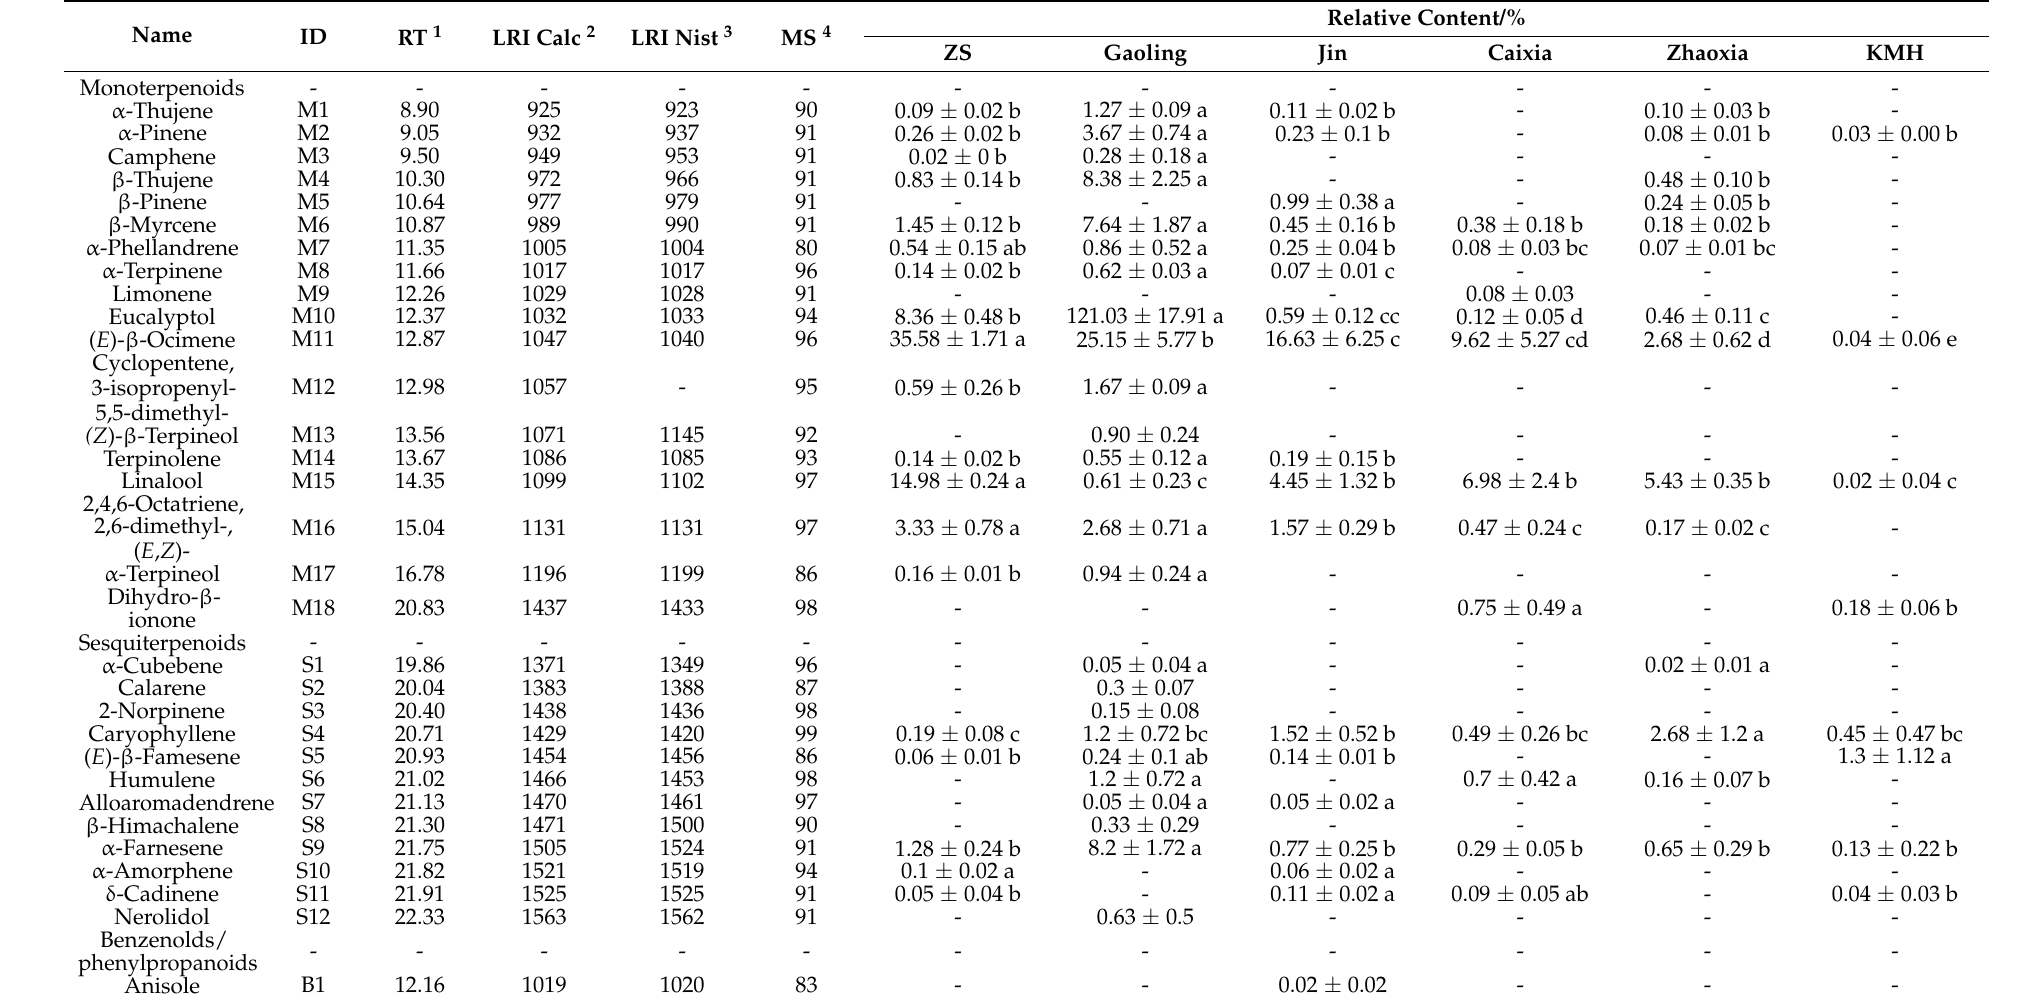
Table 1. Volatile compounds detected by HS–SPME–GC–MS in different Hedychium